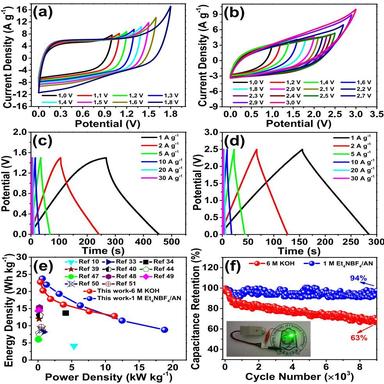
Electrochemical performance of JPC electrode based symmetric button cells: (a) CV curves of the cell in 6 M KOH electrolyte at different potential windows (50 mV s1 ), (b)CV curves of the cell in 1 M Et4NBF4/AN electrolyte at different potential windows (50 mV s1 ), (c) GCD curves of with the cell in 6 M KOH electrolyte in an operation window of 1.5 Vat differentcurrent densities, (d) GCD curves of the cell in 1 M Et4NBF4/AN electrolyte in an operation window of 2.5 V at different current densities, (e) Com